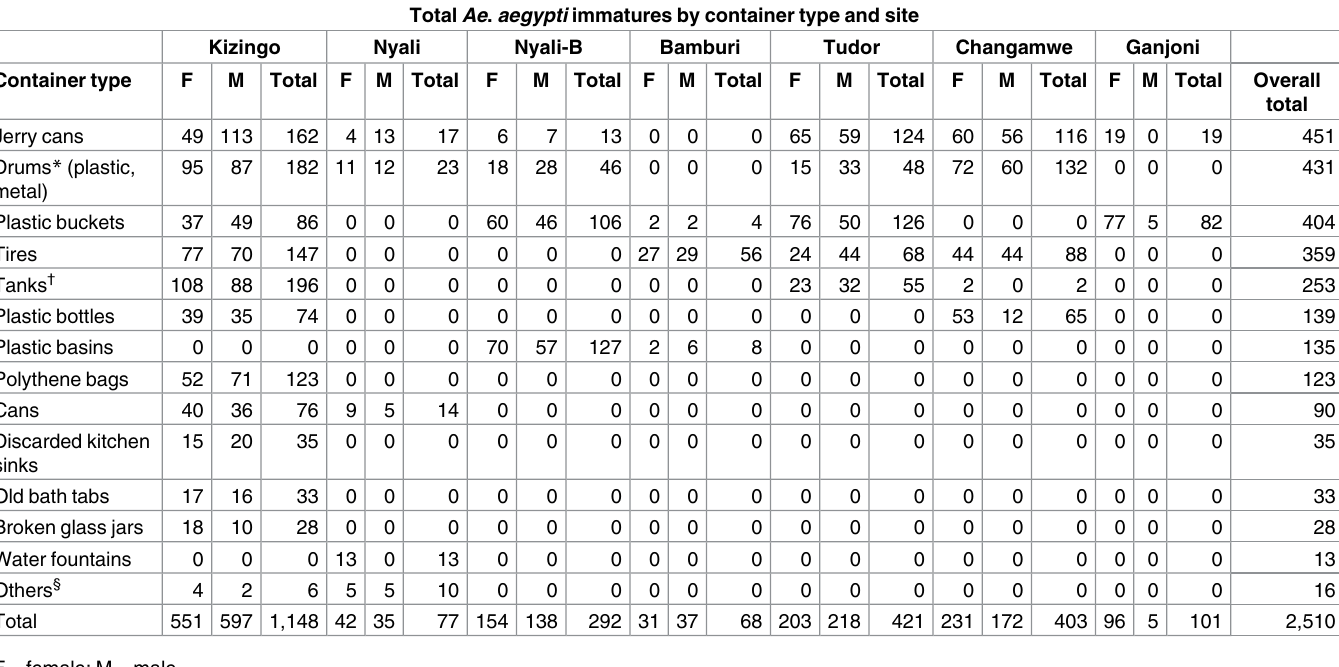
Table 4. Overall rank distribution of immature Ae . aegypti totals by site and container type in Mombasa city during the outbreak. Total Ae . aegypti immatures by container type and site